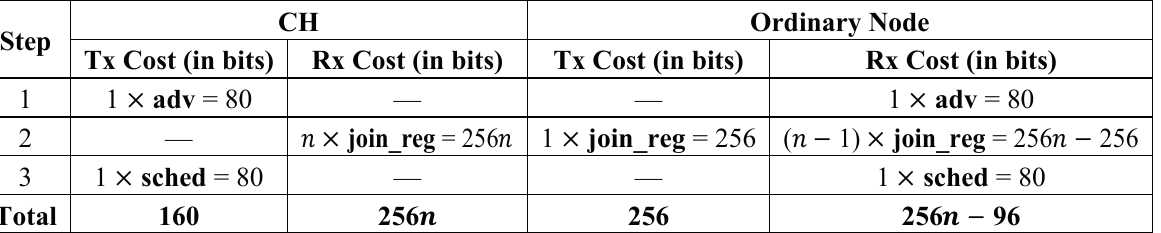
Table 10. Communication cost of SecLEACH in setup phase.